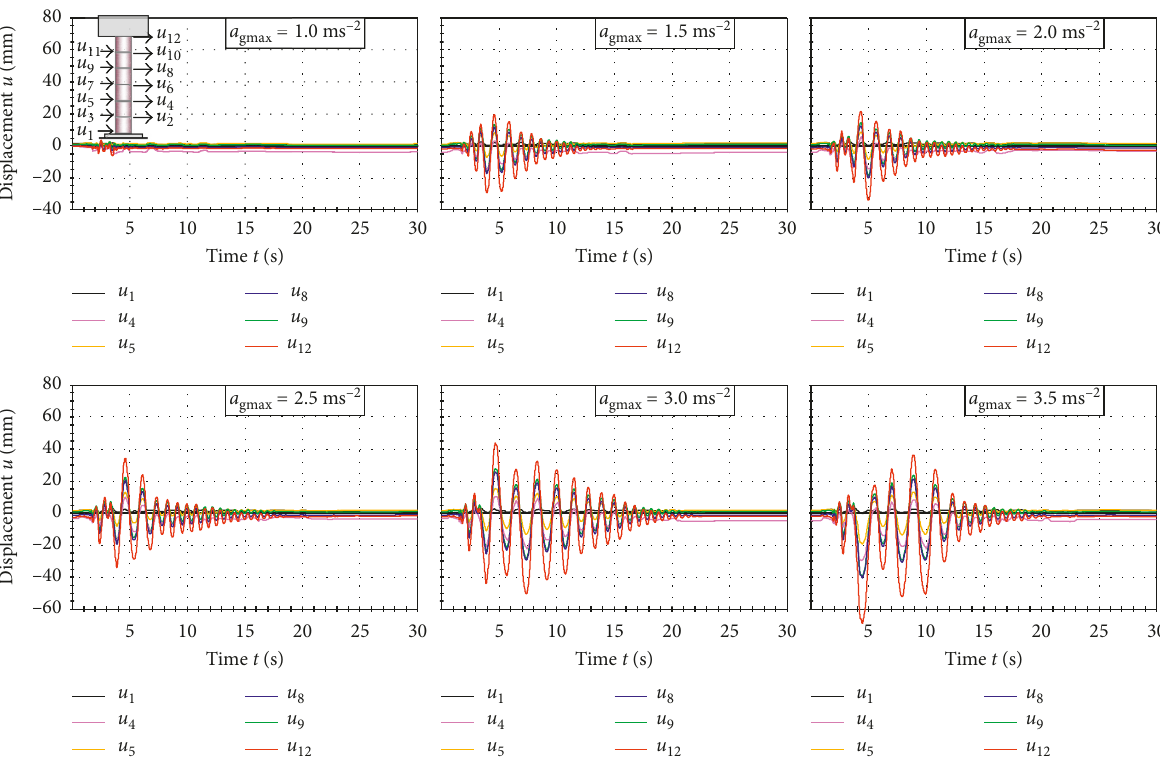
Figure 12: Horizontal displacements u 1 , u 4 , u 5 , u 8 , u 9 , and u 12 of the column S6m for the Ston accelerogram at some a gmax